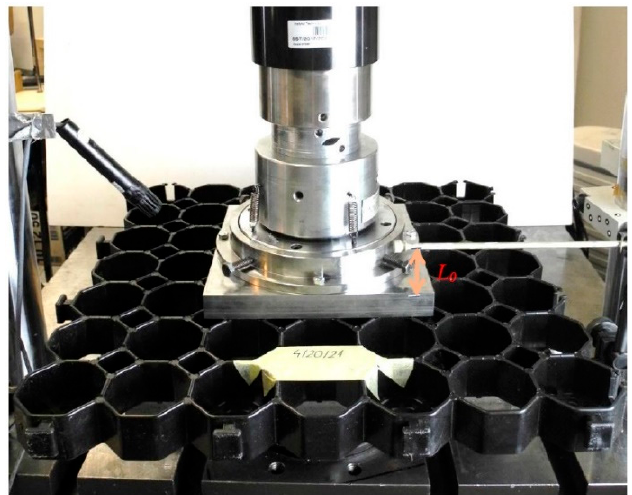
Figure 13. View of the geocell fixed in the strength machine.